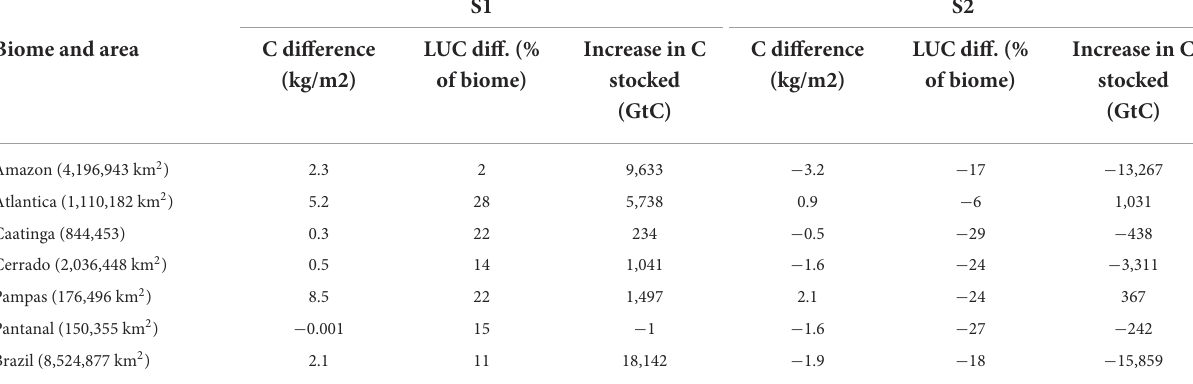
TABLE 3 Difference in total carbon stocks from the first 15 to the last 15 years of the simulation, percent of the biomass area restored ( + ) or deforested (-), and correspondent carbon storage in the land surface for each simulation. S1 S2 Biome and area C difference LUC diff. (kg/m2)